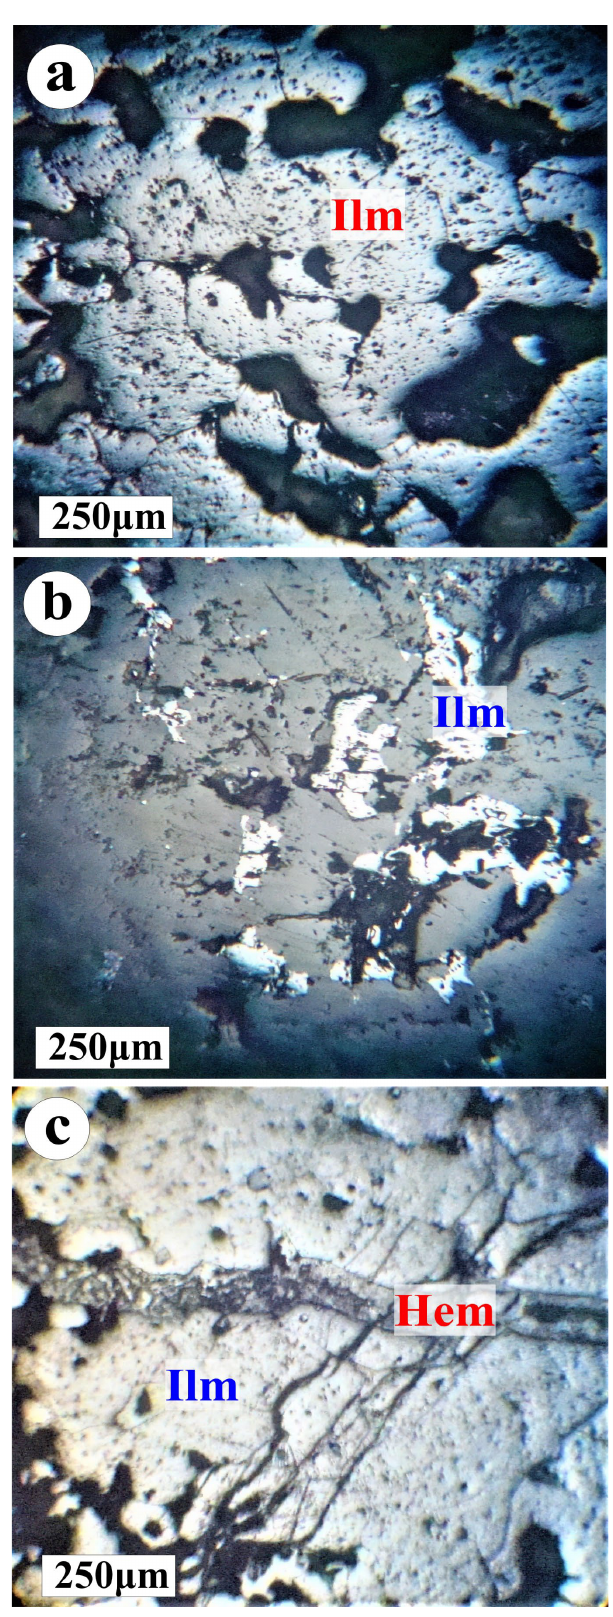
Figure 6. Polished section of an ilmenite crystal showing ( a ) reflected light photomicrographs, showing rounded fine-grained ilmenite (Ilm); ( b ) isolated ilmenite (Ilm) in gabbro; ( c ) hematite (Hem) cutting ilmenite (Ilm) crystals.